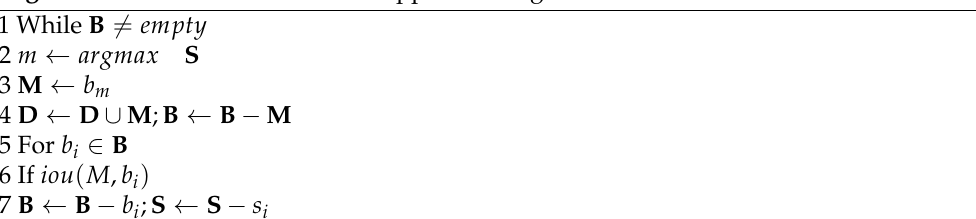
Algorithm 1 The Non-Maximum Suppression algorithm